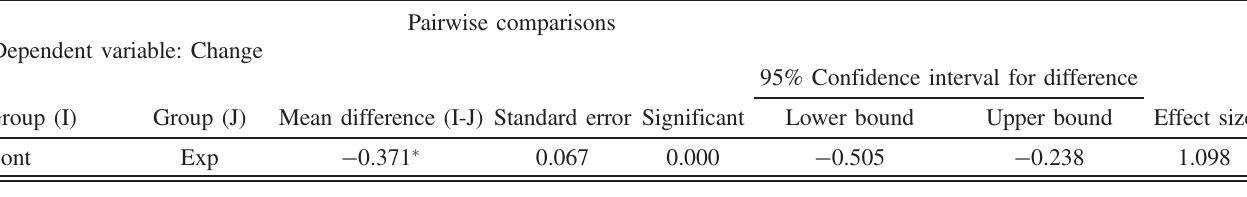
TABLE XII. A pairwise comparison between the experimental group and the control group (end of the winter 2015 semester) for the certainty or simplicity of knowledge factor in winter